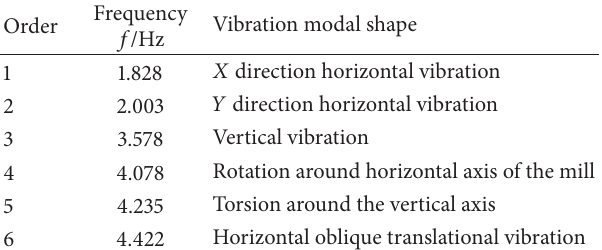
Table 2: Vibration